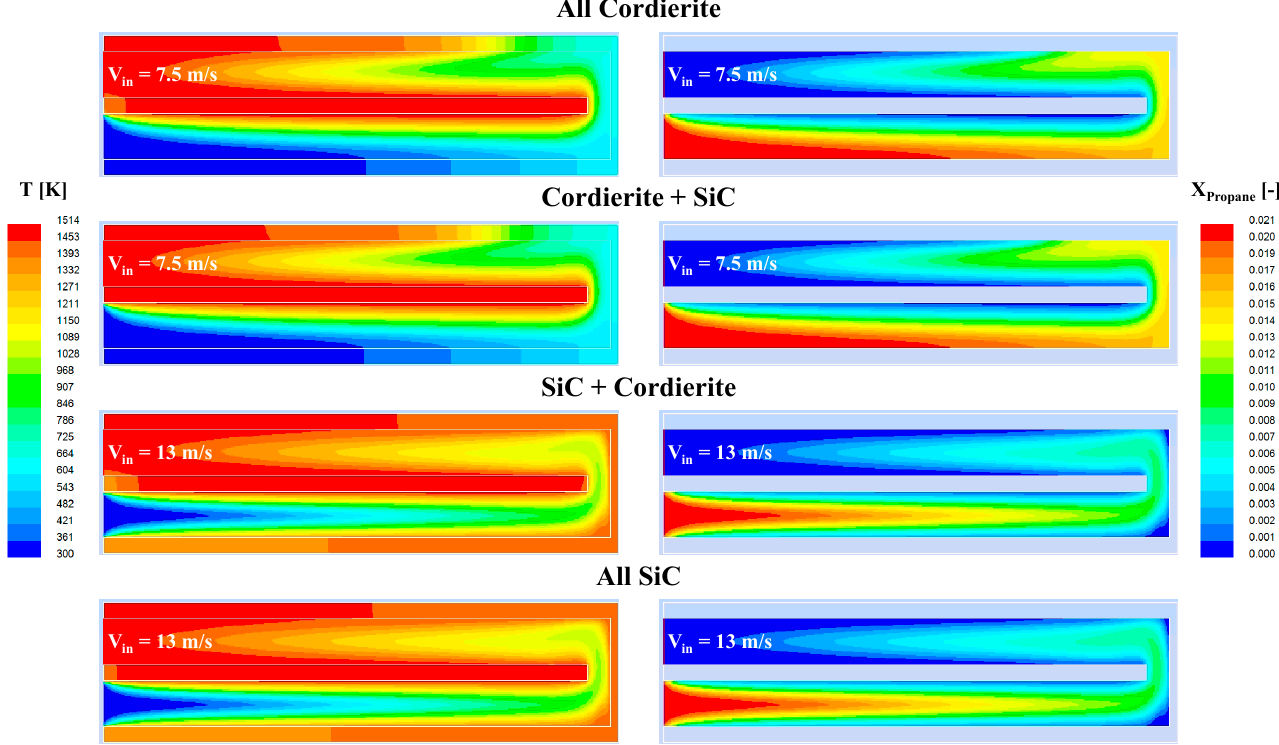
Figure 9. Maps of temperature, T, and propane mole fraction, X Propane , at the highest values of V in that still allowed for complete fuel conversion: All Cordierite; Cordierite + SiC; SiC + Cordierite; All SiC. A scaling factor equal to 2 was used to scale the computational domain along the transverse direction.